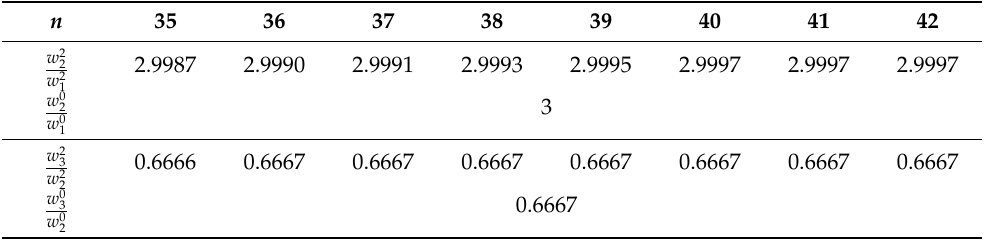
Table 2. Weight ratios under different n values.